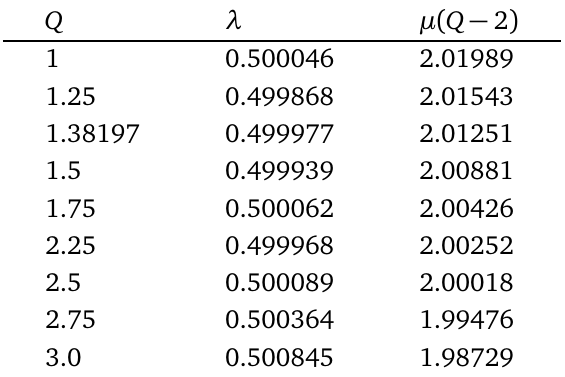
Table 3.1: Numerical determination of the coefficients (cid:21) and (cid:22) in Eq.